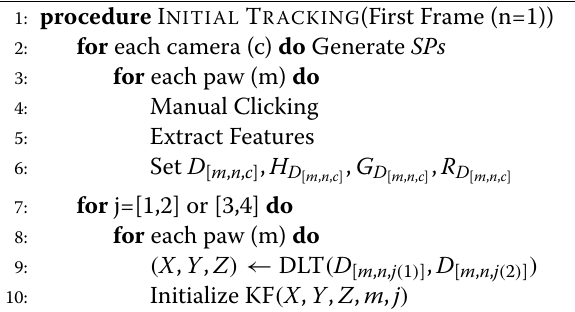
Algorithm 1 The presented algorithm includes an ini- tialization step for the first frame which needs manual clicking by user. The variables m , n , c , and i are paw index, frame number, camera number, and superpixel number, respectively. The parameter j keeps two same side cam- eras (cameras 1 and 2 or cameras 3 and 4) index to use 3D reconstruction information. H , G , and R are the related hue, green, and red channels, respectively. D , U , and V are the detected paw, coordinate in the horizontal direction of an image plane, and coordinate in the vertical direc- tion of the image plane, respectively. The parameters X , Y , and Z are coordinates in 3D. SP shows superpixels. DLT and DLTI are direct linear transform and direct lin- ear transform inverse which can be calculated based in equation 1. The initial tracker generates superpixels for the entire image and the user select the paws in each cam- era image plane. It should be noted that we have four KFs for the